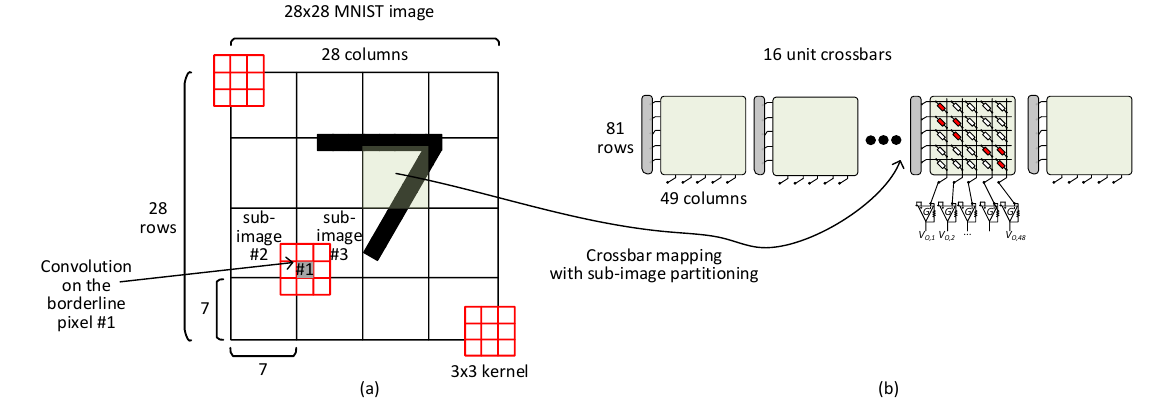
Figure 3. ( a ) The convolution of 28 × 28 MNIST image with 3 × 3 kernel using the sub-image parti- tioning. ( b ) The memristor crossbar for the sub-image convolution using the sub-image partitioning. Here, the borderline rows and columns between two neighboring sub-images are included in the crossbar’s row number of 81(=9 × 9). When the crossbar’s column number is calculated, only the number of output pixels of the convolution should be considered. By doing so, the crossbar’s column number is equal to the sub-image size of 49(=7 × 7).